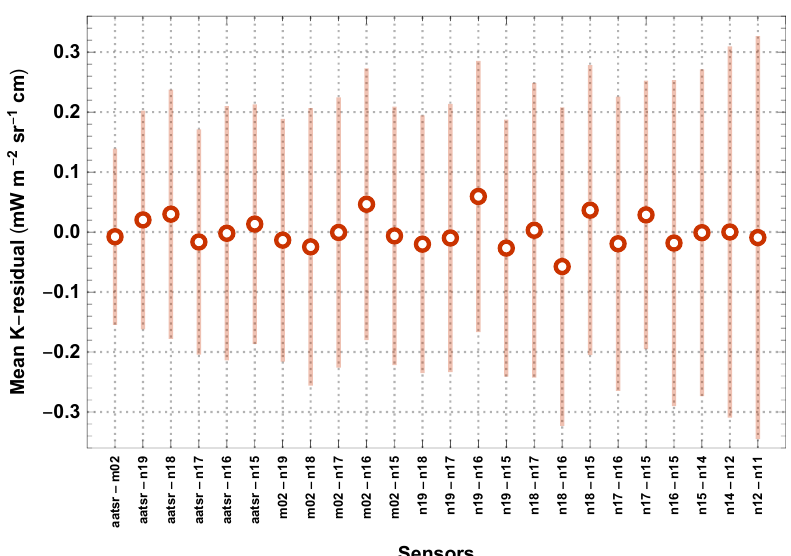
Figure 4. Mean and standard deviation of the harmonised K -residual distribution for each matchup